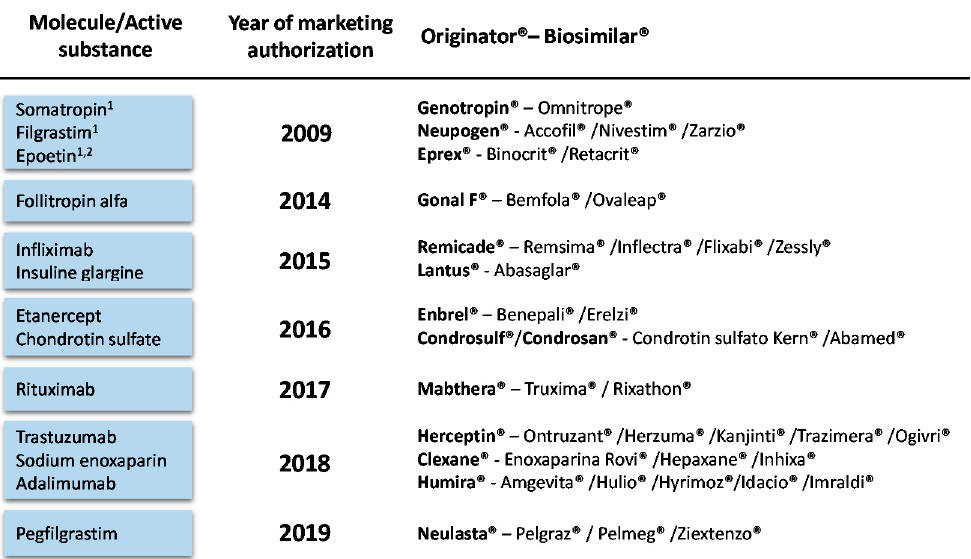
Figure 5. Biosimilar medicines effectively marketed in Spain as of December 2019. 1 Biosimilars marketed before 2009 (2009 is the first year with available consumption data). 2 For the purpose of this study, epoetin zeta and alfa are considered as a single molecule. Bevacizumab and teriparatide biosimilars have been recently marketed in Spain (September 2019 and June 2020, respectively) but they are not included in this analysis.